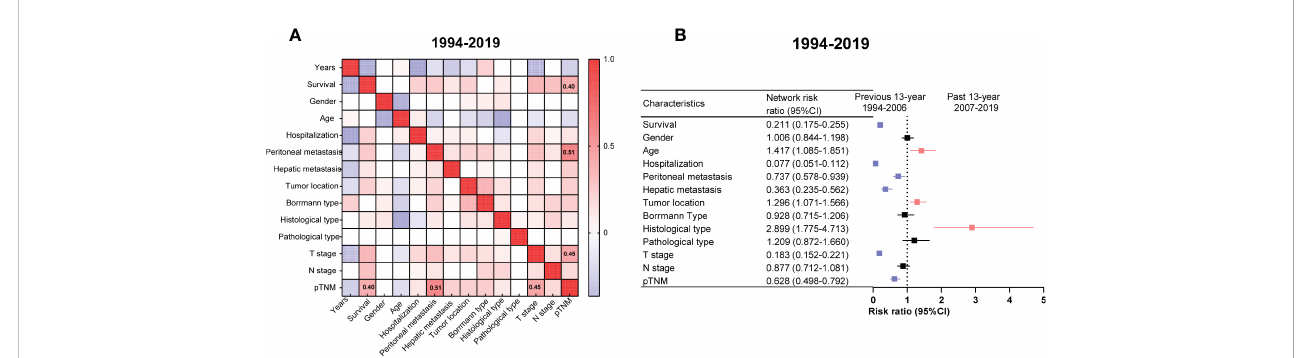
FIGURE 3 Correlation networks among the clinicopathologic characteristics of gastric cancer (GC) from 1994 to 2019 and relative risk (RR) of GC clinicopathologic characteristics between the PRE and PAS groups. (A) The correlation networks show different pro fi les of correlations among the clinicopathologic characteristics of GC from 1994 to 2019. Kendall ’ s tau-b was used for the correlation analysis. (B) The RR of clinicopathologic characteristics for GC. Symbols and error bars: black, P > 0.05; blue, P < 0.05 and RR <1; red, P < 0.05 and RR >1.